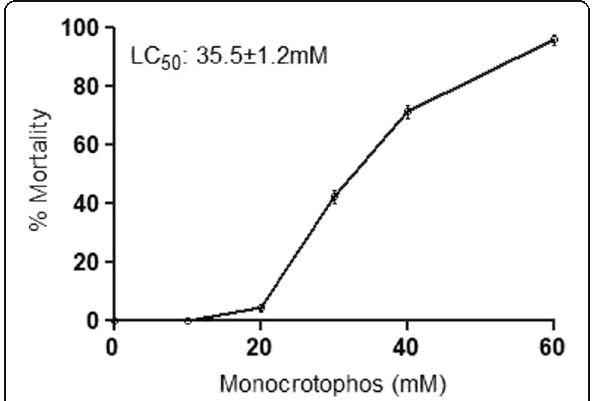
Fig. 1 Toxicity of monocrotophos to Caenorhabditis elegans after 4 h of exposure. Values are mean ± SE ( n =